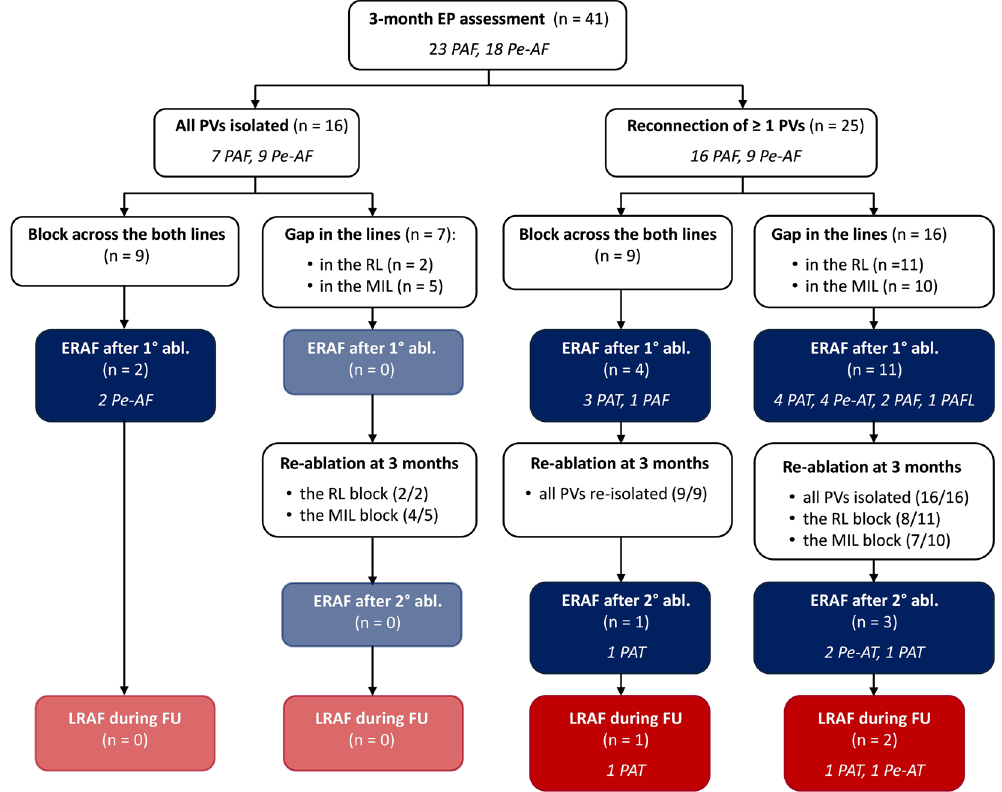
Figure 6. Flow-chart diagram of the clinical course after the index ablation and the 3-month invasive evaluation (with re-ablation). EP, electrophysiology; PAF, paroxysmal atrial fibrillation, Pe-AF, persistent atrial fibrillation; PV, pulmonary vein; RL, roof line; MIL, mitral isthmus line; ERAF, early recurrence of atrial fibrillation; PAT, paroxysmal atrial tachycardia; Pe-AT, persistent atrial tachycardia; LRAF, late recurrence of atrial fibrillation; FU,